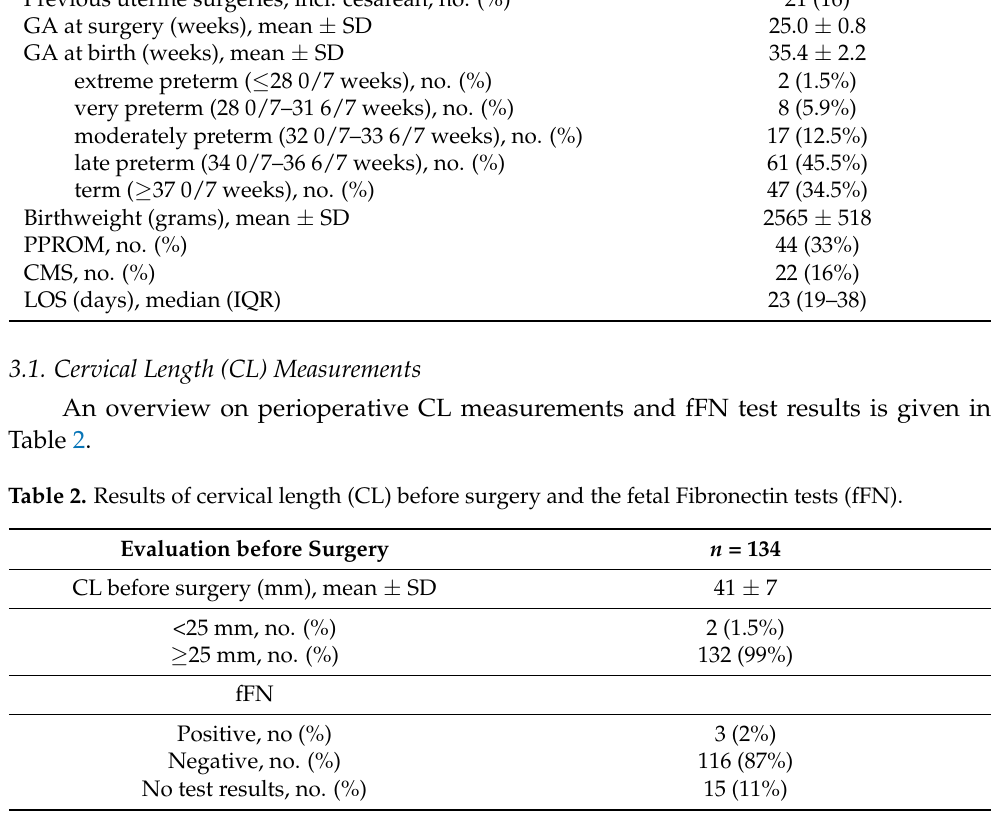
Table 1. Maternal and fetal characteristics of the Zurich study cohort. Demographics n = 134 Maternal age (years), mean ± SD 31.9 ± 5 Nulliparous, no. (%) 58 (43) Body mass index (kg/m 2 ), mean ± SD